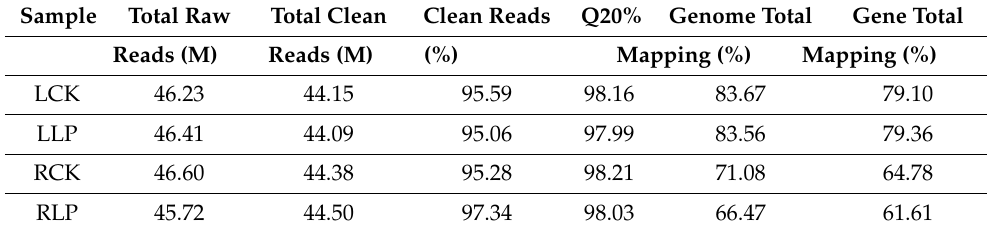
Table 1. Sequencing quality of M. mandshurica under low phosphorus